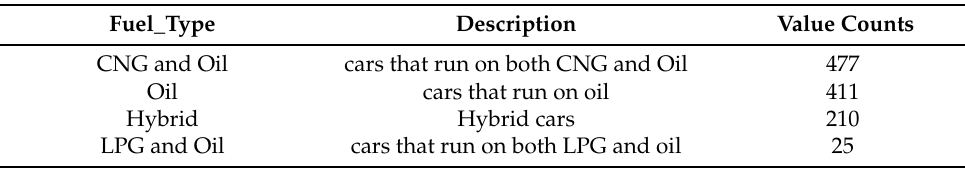
Table 5. After processing the feature fuel